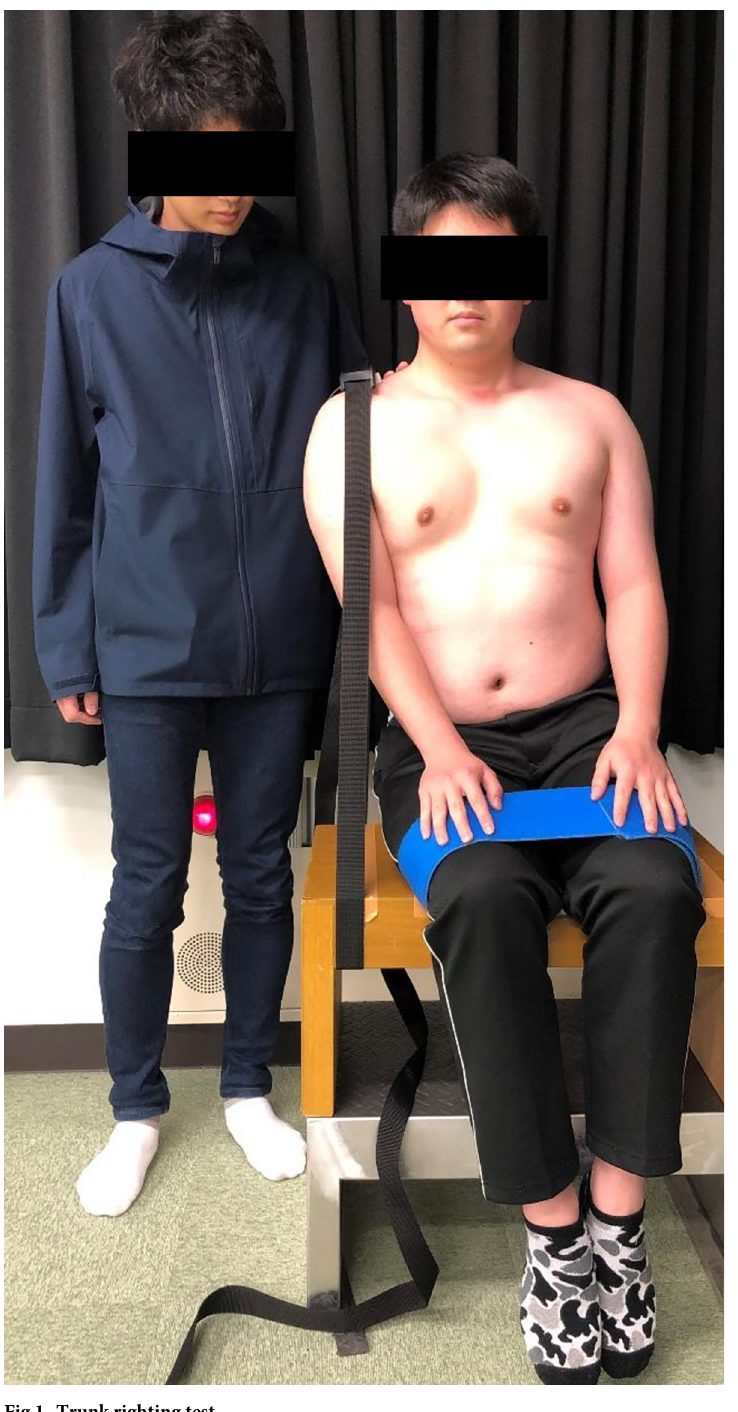
Fig 1. Trunk righting